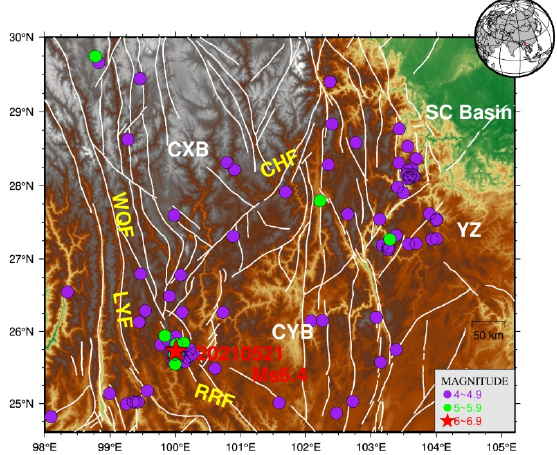
Figure 1. Regional tectonic setting of the 2021 Yangbi Ms 6.4 earthquake. The white line in the figure represents the distribution of active faults in the study area. CXB: Chuanxibei Sub-Block; SC Basin: Sichuan basin; YZ: Yangtze Craton; CYB: Central Yunnan Sub-Block; WQF: Weixi-Qiaohou Fault; RRF: Red River Fault; LYF: Lanping-Yunlong Fault; CHF: Chenghai Fault. The dots in the figure represent the magnitude: the purple dots represent earthquakes with a magnitude between Ms 4.0 and Ms 4.9; the green dots represent earthquakes with a magnitude between Ms 5.0 and Ms 5.9; the red star represents the 2021 Yangbi Ms 6.4